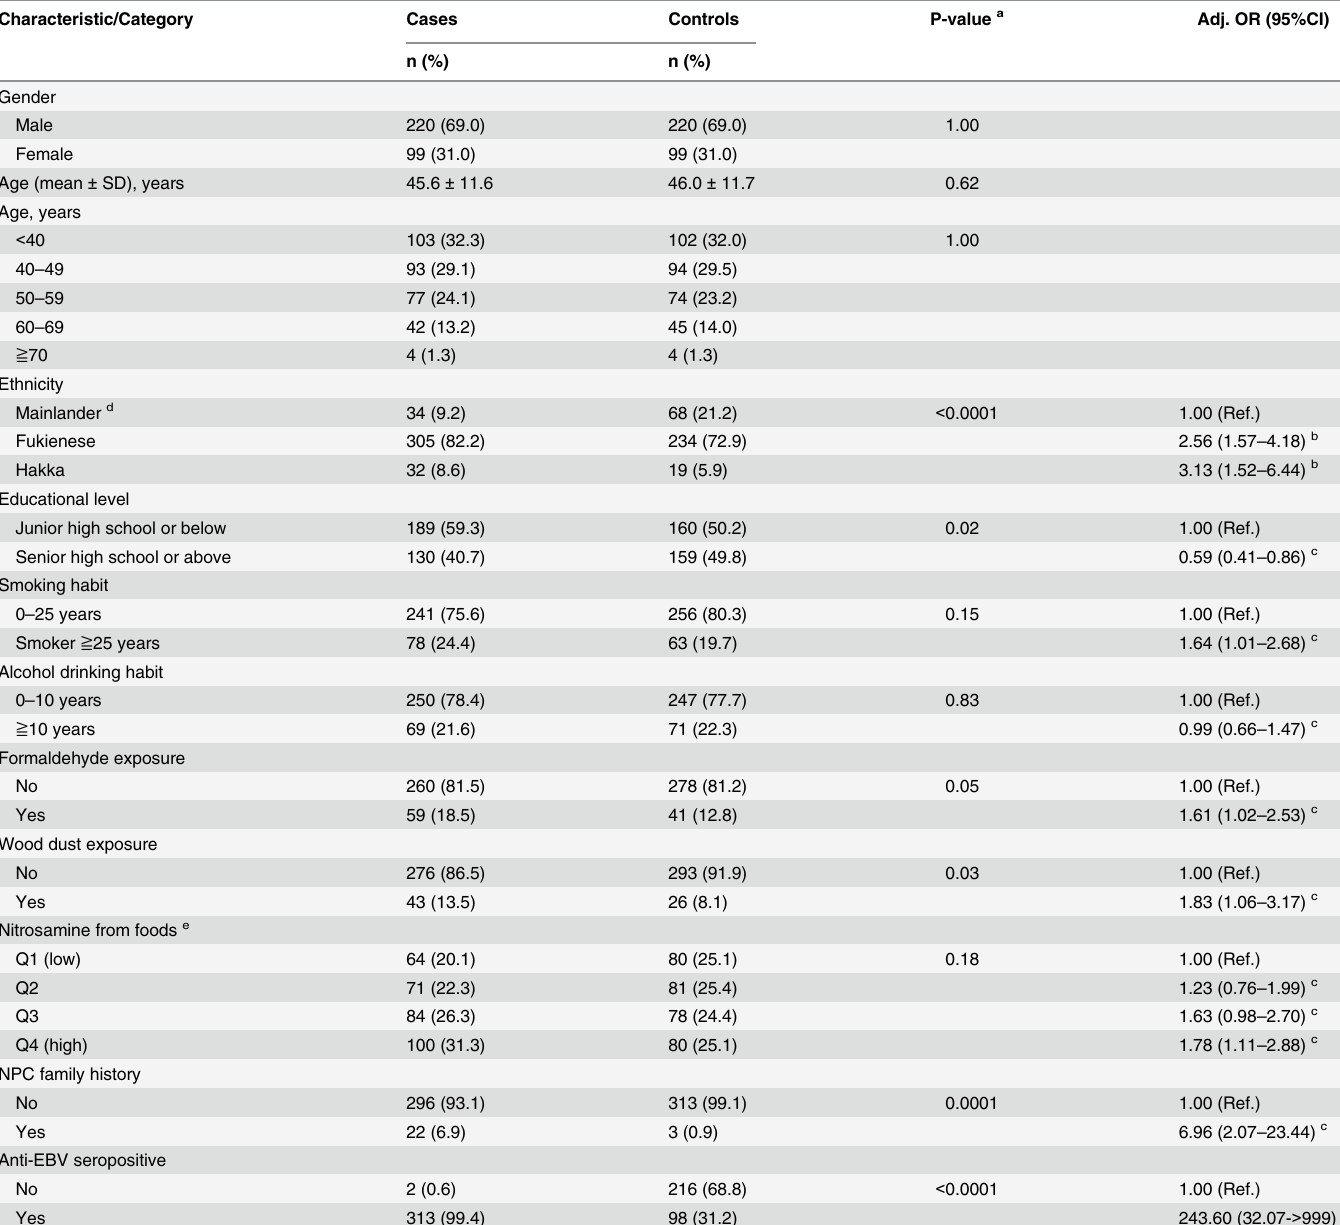
Table 1. Sociodemographics, Lifestyle, and Viral Status of 319 Nasopharyngeal Carcinoma Cases and 319 Matched